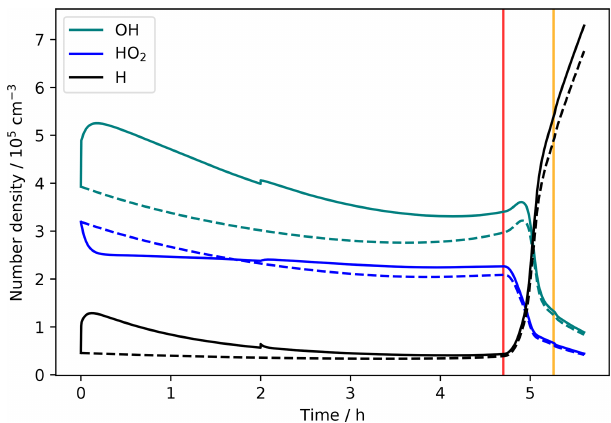
Figure 9. Concentrations of H, OH, and HO 2 at 75km altitude for RUN1. The solid lines depict the sprite model simulation, and the dashed lines depict the no-sprite simulation. The vertical orange line indicates the time of sunrise, and the vertical red line indicates the time when the model starts to account for scattered sunlight (at a solar zenith angle of 98 ◦ ).